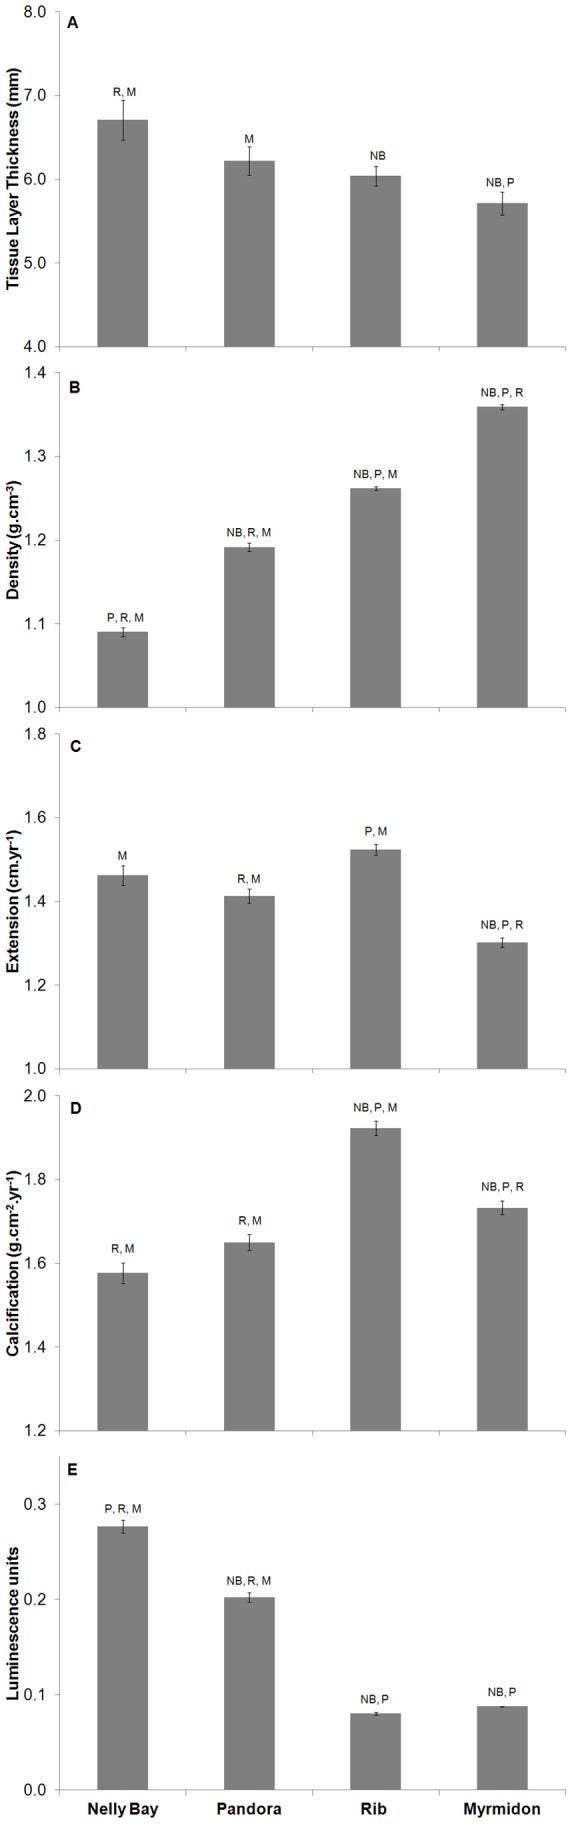
Growth characteristics averaged by reef site (± se), 1980–2003.(A) tissue layer thickness, (B) skeletal density, (C) linear extension rate, (D) calcification rate, and (E) annual luminescence range. (reef sites arranged from inshore to offshore according the water quality characteristics (Table 2). Statistically distinguishable sites are identified by the letters above each bar (NB-Nelly Bay, P-Pandora Reef, R-Rib Reef and M-Myrmidon Reef) at α = 0.05.